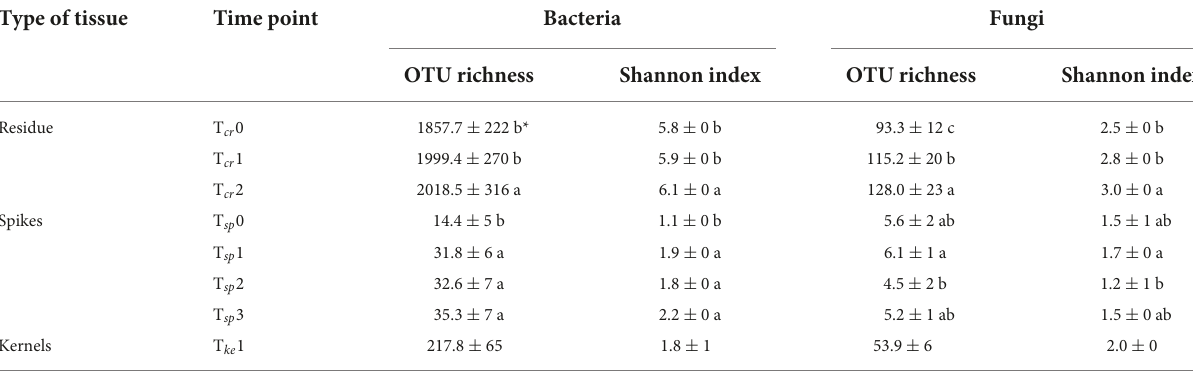
TABLE 4 The microbial richness (number of OTUs) and Shannon index of diversity for bacteria and fungi in crop residue, wheat spikes and kernel tissues collected at different time